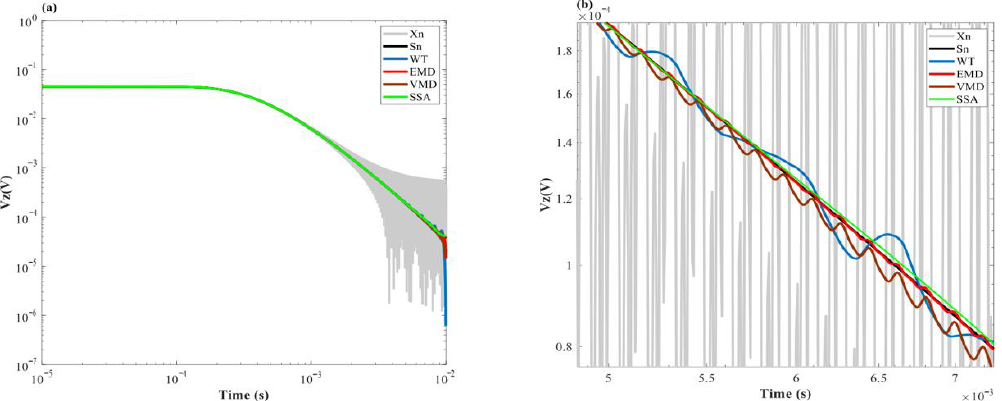
Figure 10. Comparison of de-noising results by different methods. ( a ) Overall view; ( b ) partial enlarged view.